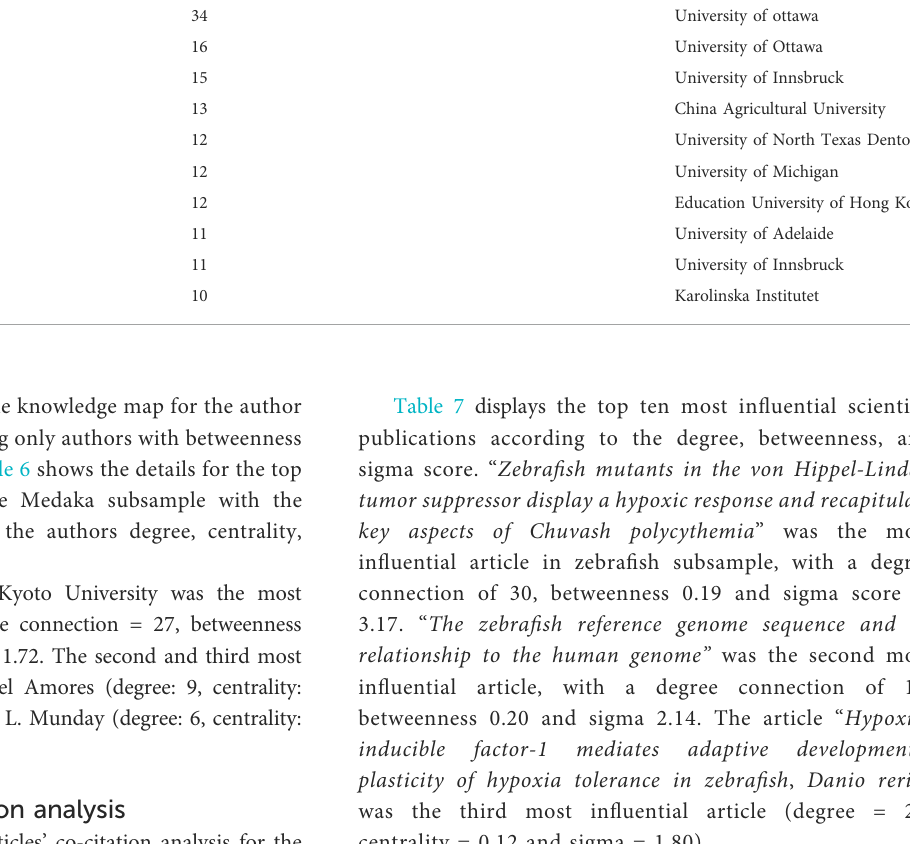
TABLE 4 Top ten most productive authors regarding research on zebra fi sh and climate change. Top authors for on zebra fi sh and climate